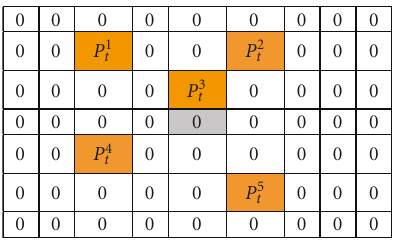
Table 2: The observation set.